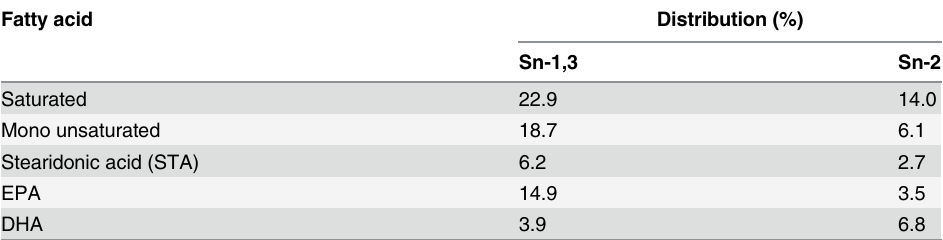
Table 1. Positional distribution of various fatty acids in anchovy